Question: Provide a one-line summary of what is displayed.
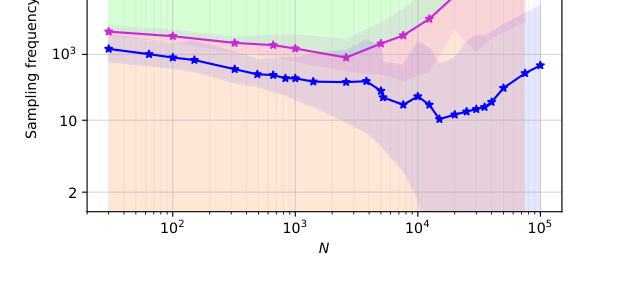
Answer: Sampling frequency required to achieve MaxCut advantage using QAOA p = 11. The shaded area around the solid lines corresponds to 90-10 percentiles over 100 seeds for Gurobi and 20 seeds for BURER2002. The background shading represents comparison of a quantum computer with BURER2002 solver corresponding to modes in Fig. 1. Each quantum device can be represented on this plot as a point, where the x-axis is the number of qubits, and the y-axis is the time to solution. Depending on the region where the point lands, there are different results of comparisons. QAOA be- comes inefficient for large N, when sampling frequency starts to grow exponentially with N.